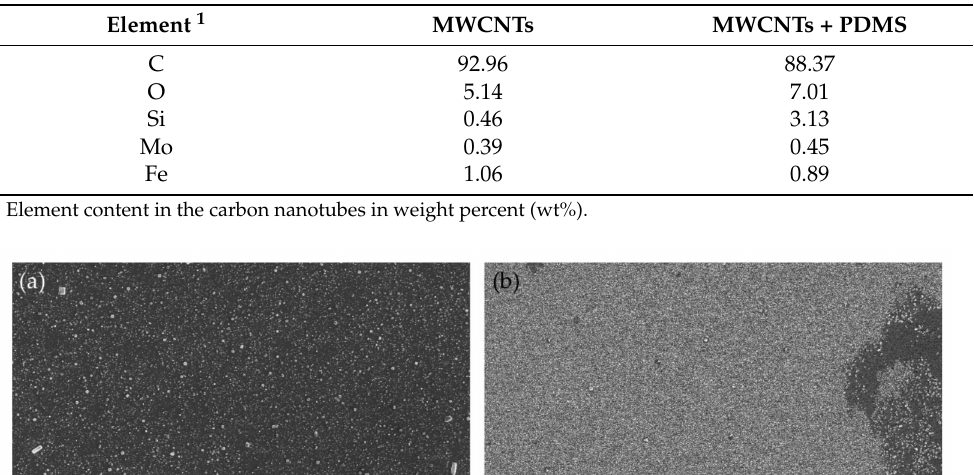
Table 4. SEM-EDS elementary analysis of carbon nanotubes (MWCNTs): nonmodified and modified with PDMS.